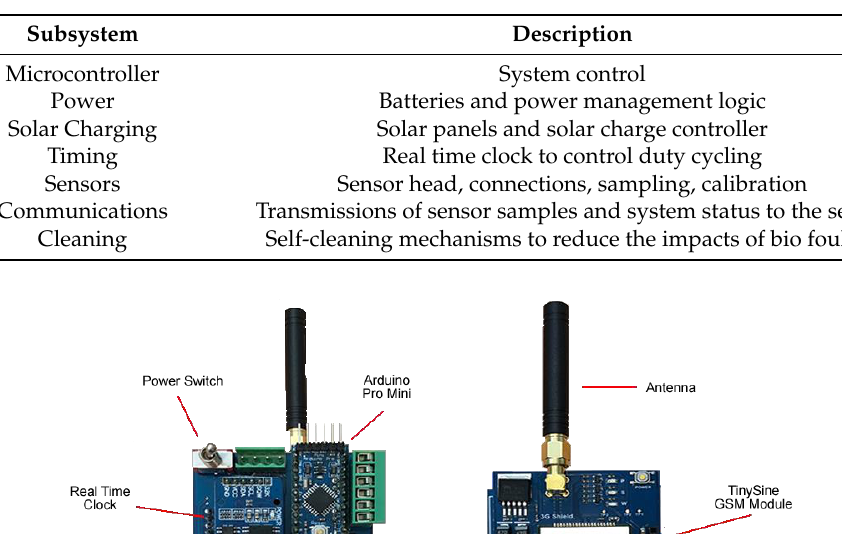
Table 3. Electronics Subsystems.